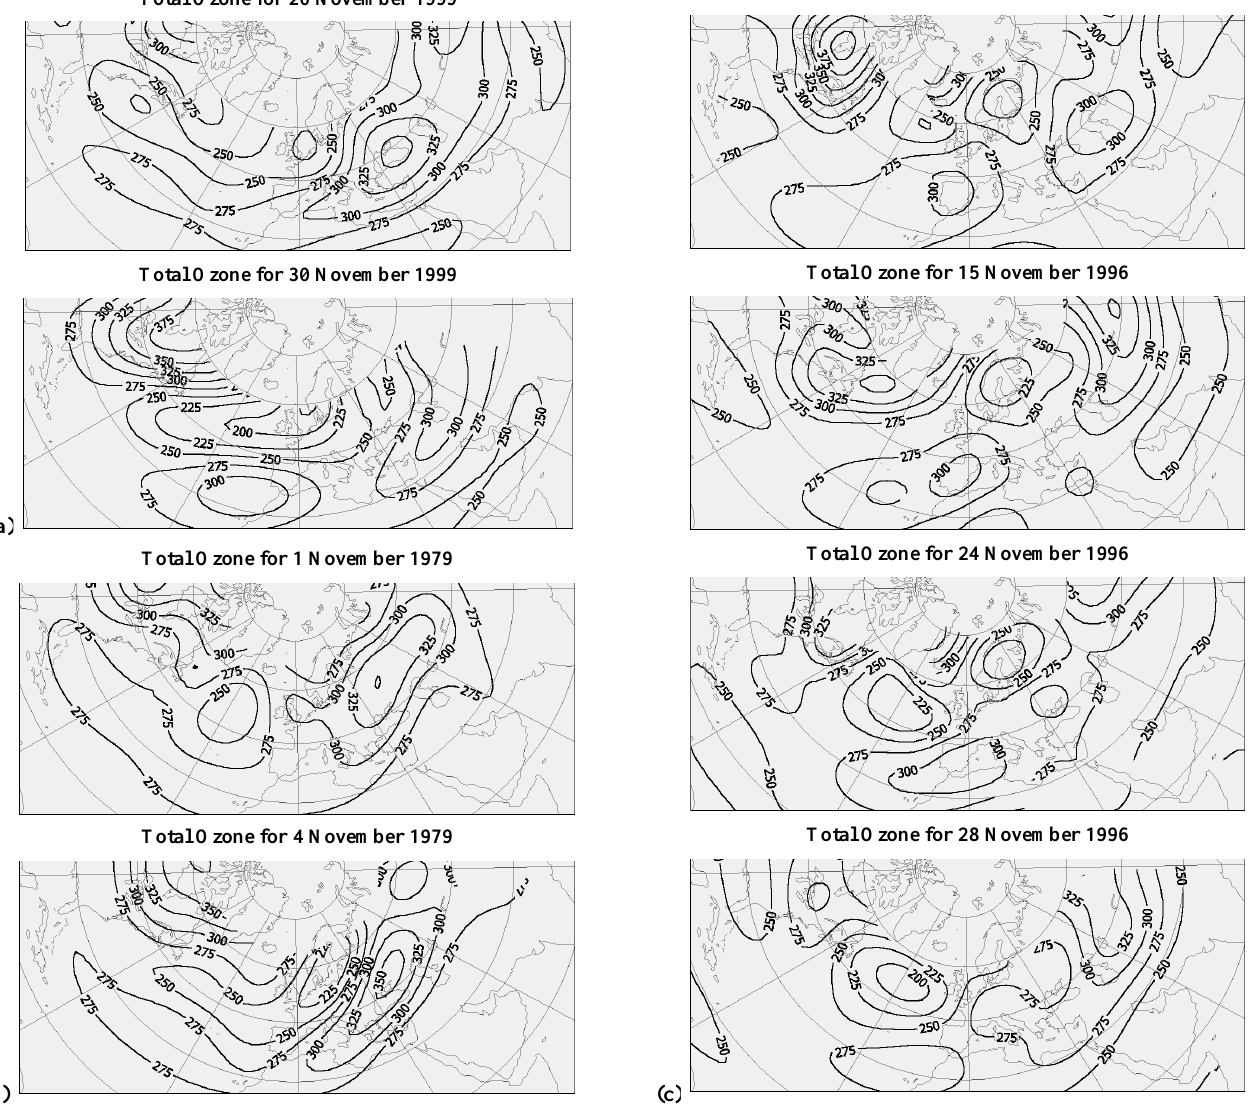
November 1979 ELO 3 episode.